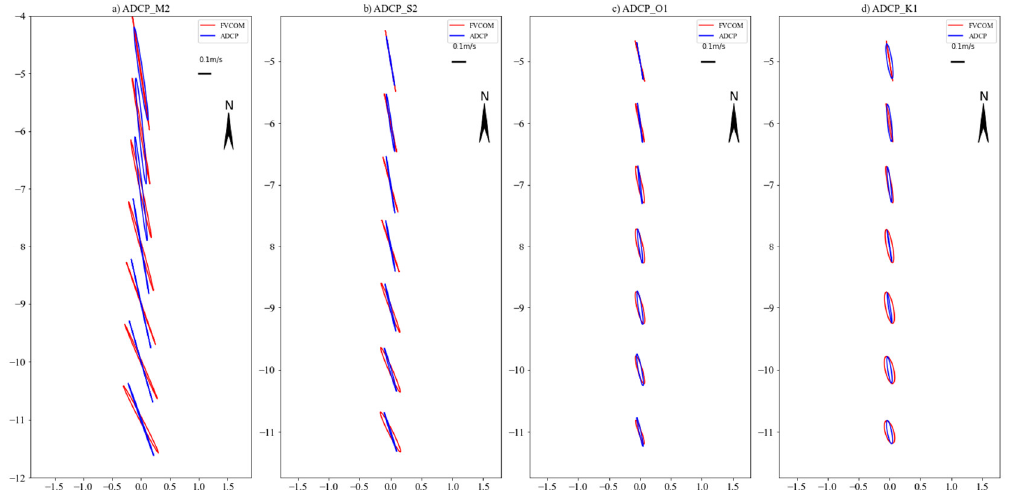
Figure 5. Vertical profiles of tidal ellipses (M 2 , S 2 , K 1 , O 1 ) at station A1: model (red) and ADCP (blue).